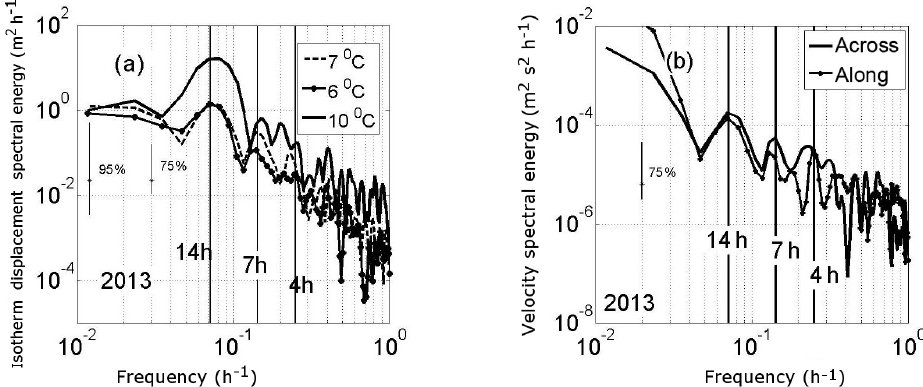
Figure 5. Spectra of (a) the vertical displacements of different isotherms and (b) bottom velocities measured at station W1 in